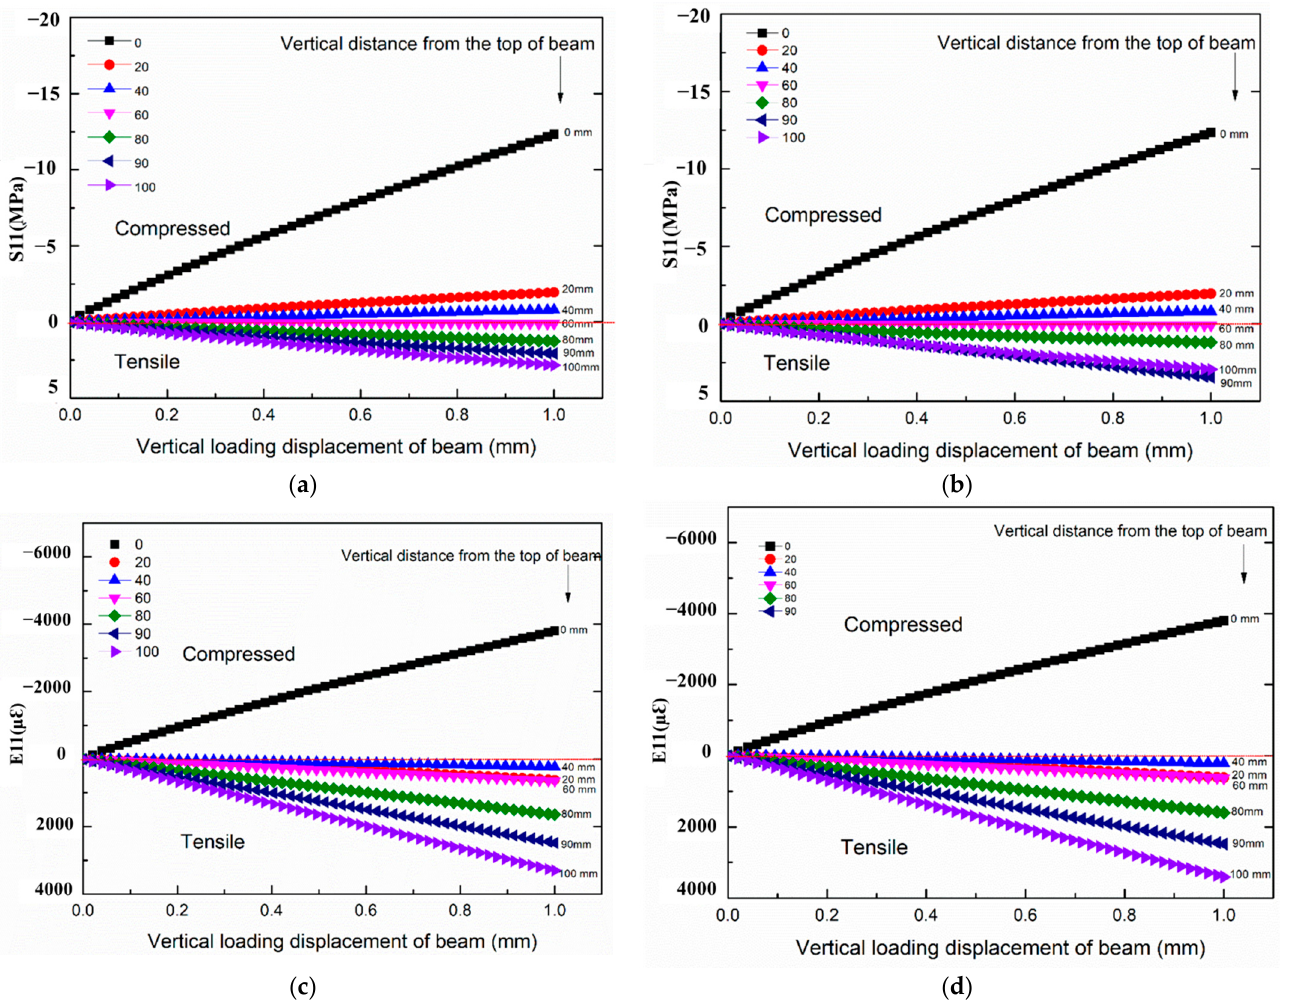
Figure 4. Change of S11 and E11 with the vertical loading displacement, ( a ) S11 of beam without sensor, ( b ) S11 of beam with I-shaped sensor, ( c ) E11 of beam without sensor, ( d ) E11 of beam with I-shaped sensor.